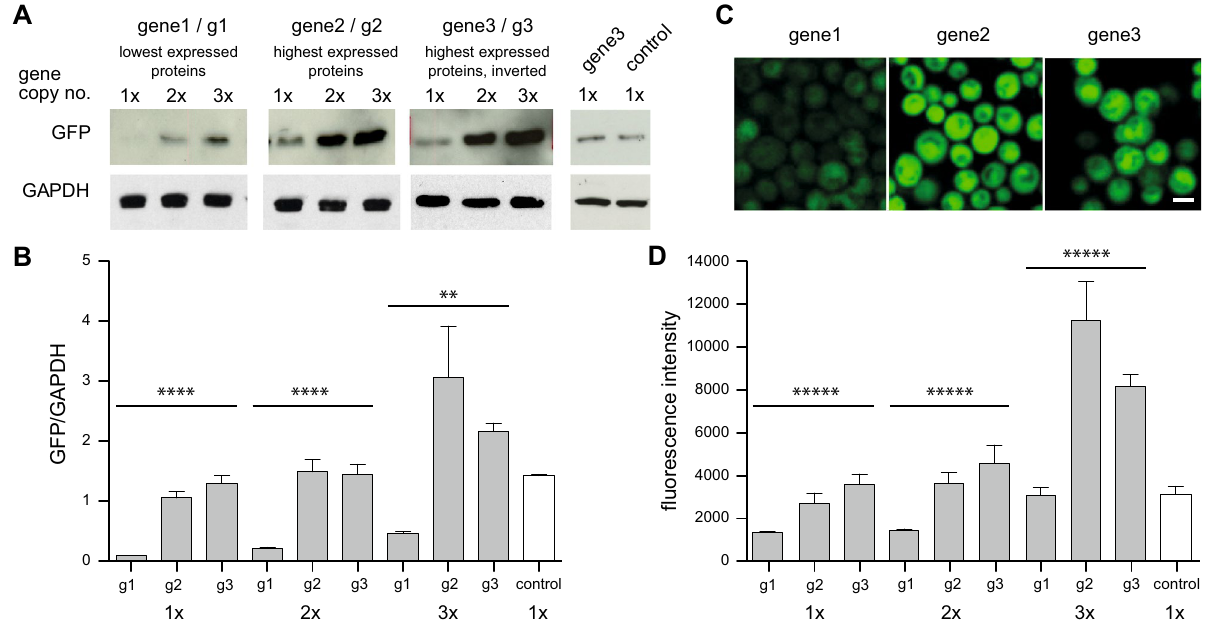
Figure 4. Steady-state protein levels of GFP. Three types of gene design were tested in combination with one to three gene copies. All designed genes are based on the weighting scheme, by which each codon of a subset of genes is multiplied with its expression level as provided by PaxDB data. Gene1 is based on the subset of the 5024 least expressed genes, gene2 is based on the 308 highest expressed genes, and gene3 is based on the inversion of the codon usage of the highest expressed genes. ( A ) Western blot analysis of crude protein extracts from yeast strains, expressing GAL1- driven GFP from one, two and three copies. Protein expression was induced for 6 h in galactose-containing medium, crude protein extracts were prepared and equal protein amounts from all samples were used for Western blotting. The membrane was probed with anti-GFP antibody. GAPDH antibody was used as a loading control. The full-sized blots are available in Supplementary Fig. S2. ( B ) Quantification of the protein levels of GFP. Densitometric analysis of the immunodetection of GFP, relative to GAPDH loading control.